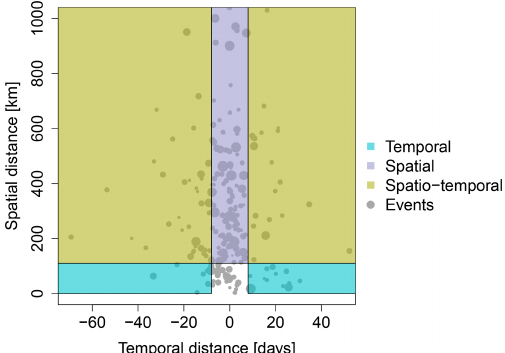
Figure 6. Each extreme event is split into parts with enhanced and reduced GPP anomalies. The centroidal distance between both parts in space and time shows whether contrasting GPP anomalies are predominantly taking place temporally, spatially, or spatiotempo- rally. Point sizes are proportional to the event’s affected